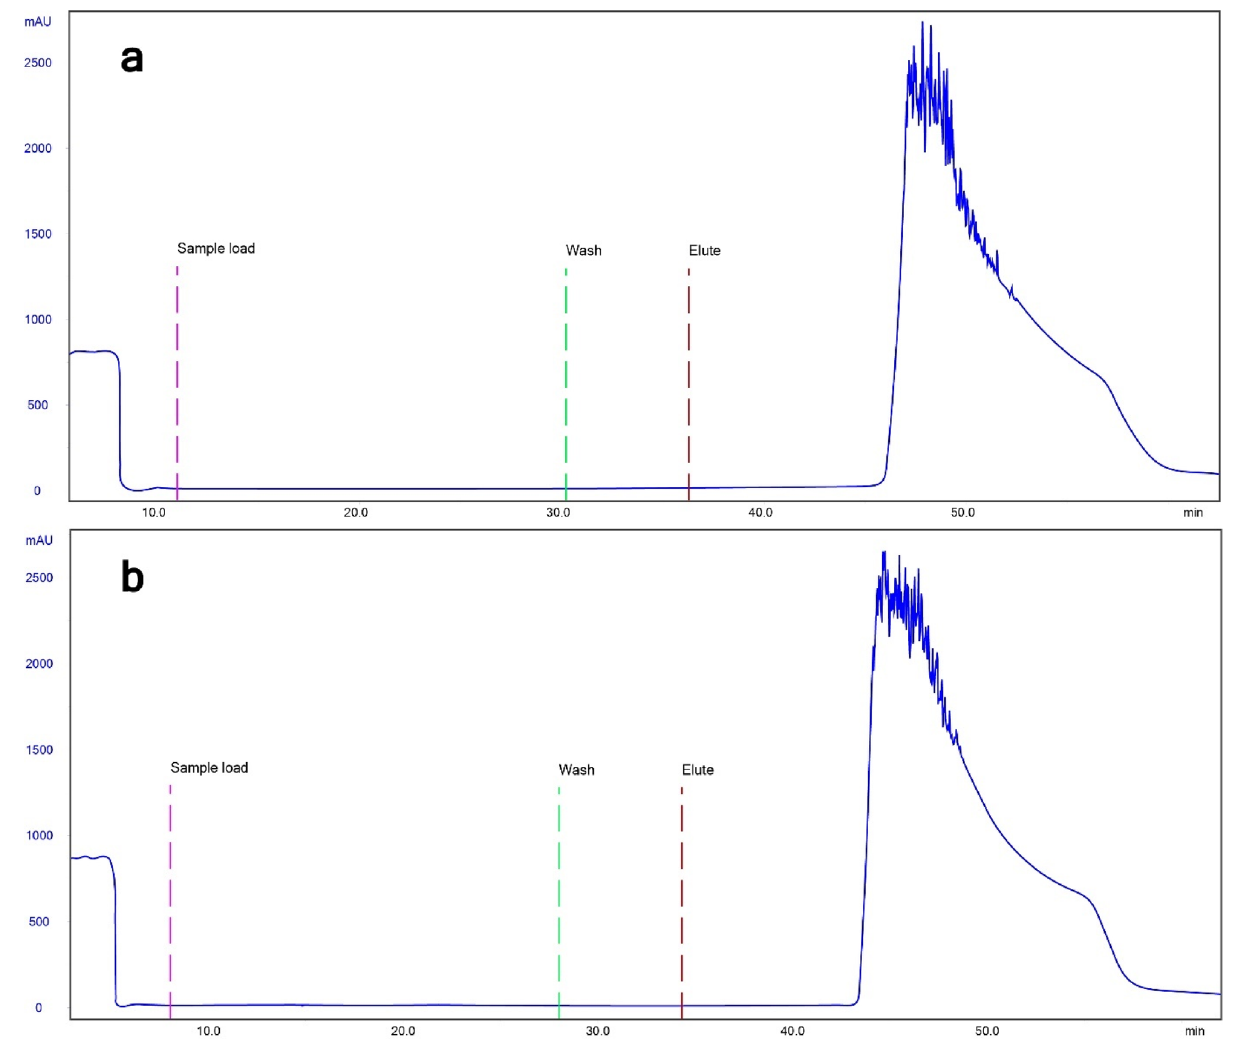
Figure 7. Chromatograms showing adsorption and elution of panitumumab (IgG2; a ) and nivolumab (IgG4; b ) for peptide A-based affinity